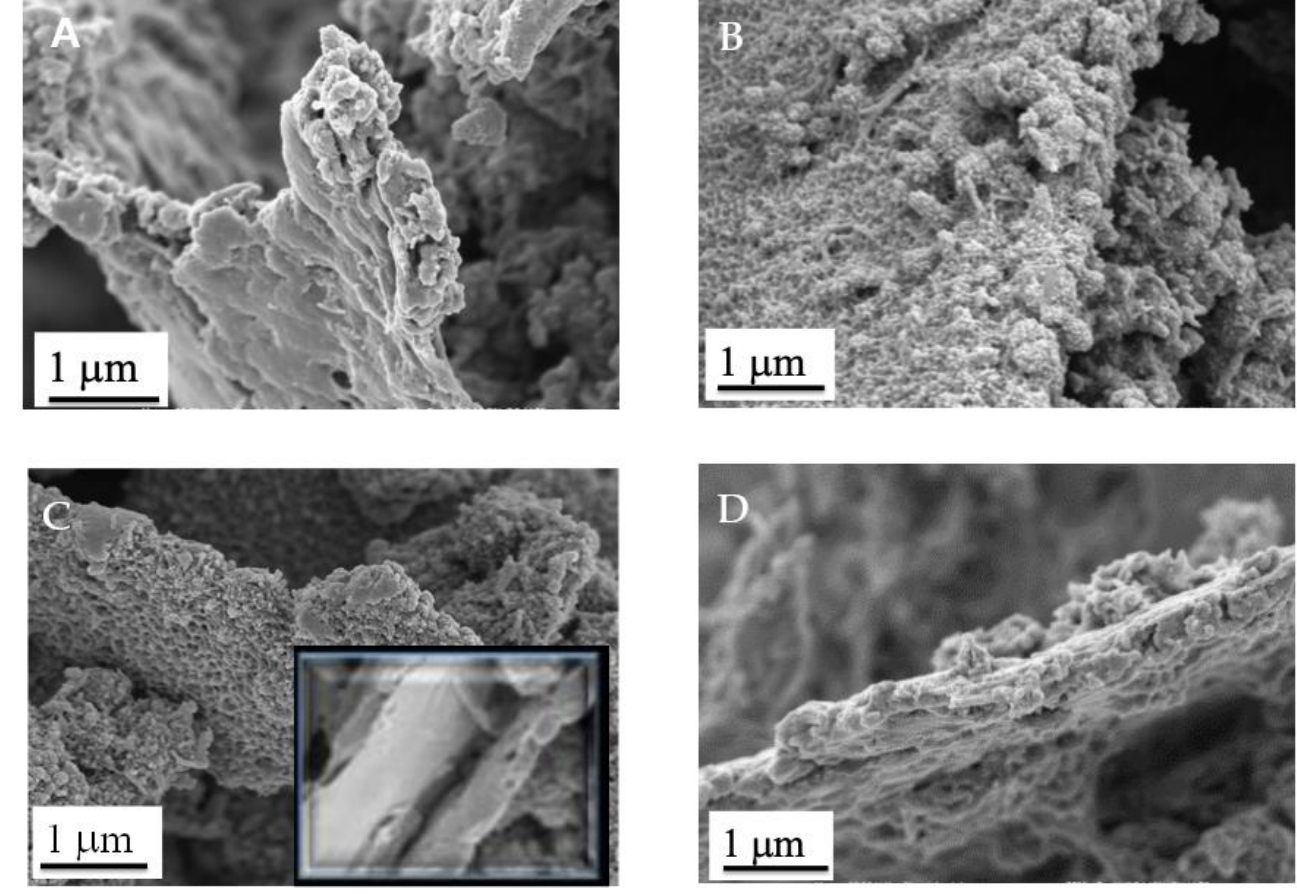
Figure 4. SEM images of PANI/PIL/GO 98/2 ( A ), PANI/PIL/GO 84/16 ( B ), PANI/PIL/GO 68/32 ( C ), and PANI/PIL/Gr 84/16 ( D ) .